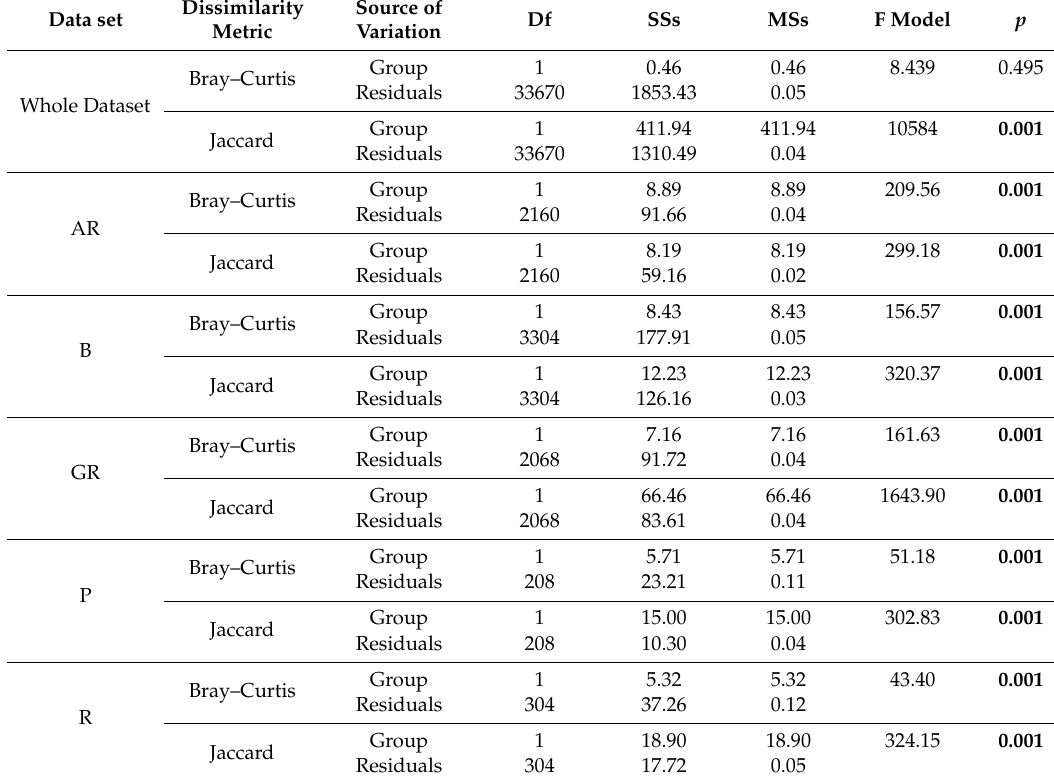
Table 6. Di ff erences in beta diversity between lichen and plant assemblages obtained using the following two measures of dissimilarity: Bray–Curtis dissimilarity (square root transformed species abundance data) and Jaccard dissimilarity (for presence / absence data). Analyses were carried out both for the whole set of 184 plots as well as for each habitat. p -values were obtained by Mantel randomization of the original plot-to-plot dissimilarity matrices (999 permutations); significant di ff erences were highlighted in bold. AR–Shrublands, B–Riparian woods, GR–Dry Banks, P–Swamps, R–Flooded